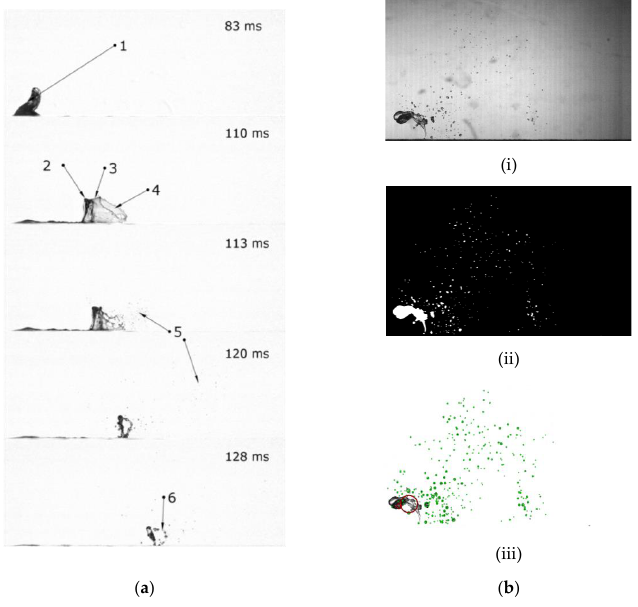
Figure 2. ( a ) Five sequent images obtained from the side of the bag-breakup for wind speed U 10 = 21.8 m/s. 1 — initial disturbance; 2 — rim; 3 — film; 4 — film rupture; 5 — film drops; 6 — rim drops. Full image width 161 mm; ( b ) Image processing sequence for a frame at 113 ms after film rupture, U 10 = 21.8 m/s, 81 mm downwind the initial disturbance, 33 mm above surface. (i) initial image; (ii) binary image with marked droplet areas; (iii) detected droplets (green circles — detected droplets; red — deleted image of rim).